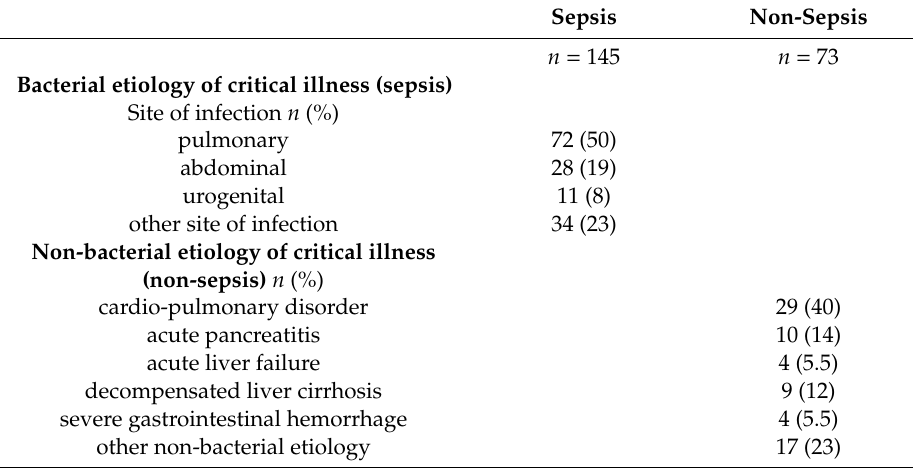
Table 2. Disease etiology of the study population leading to ICU admission.